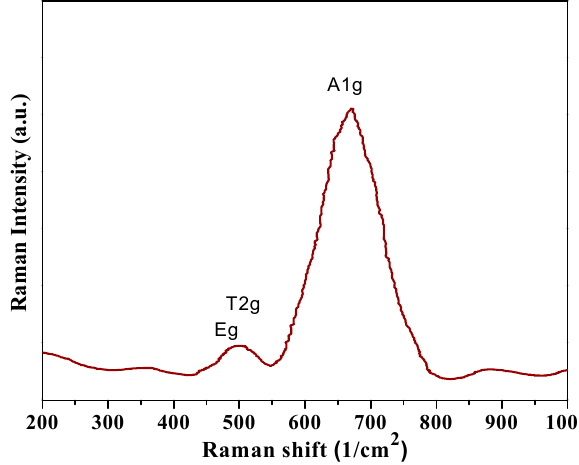
Figure 5. The Raman spectrum recorded at room temperature for MIONPs.